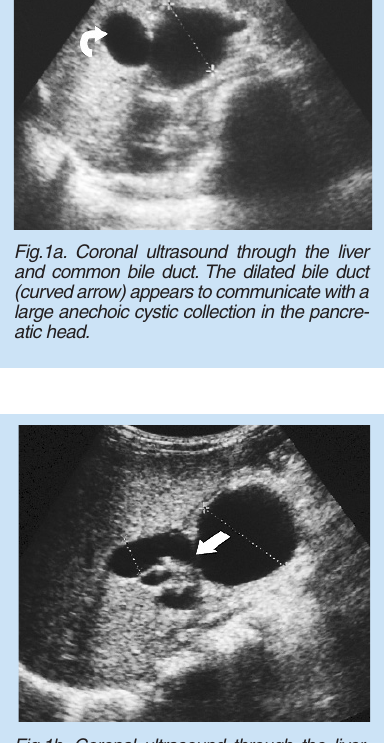
Fig.1b. Coronal ultrasound through the liver and common bile duct. The wall separating the two structures (arrow) is now visualised but is thin and almost imperceptible leading to diagnostic confusion.